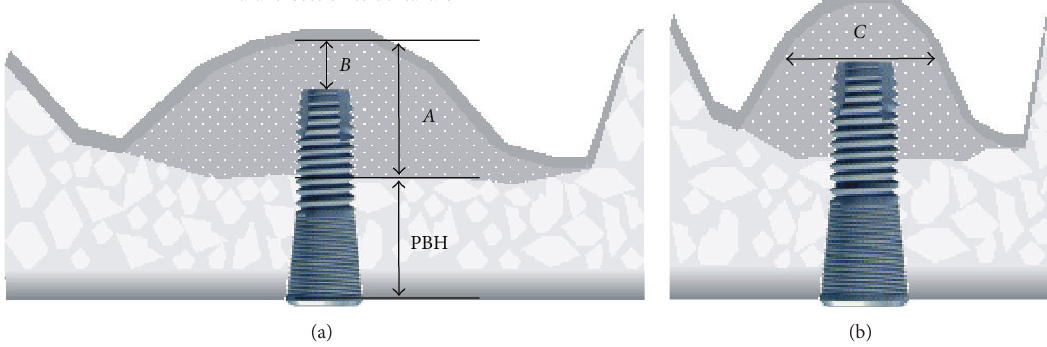
Figure 3: Schematic of the measurement points on a CBCT images PBH: preoperative crestal bone height, ( A ) total height of the bone graft, ( B ) apical height of the bone graft, and ( C ) width of the bone